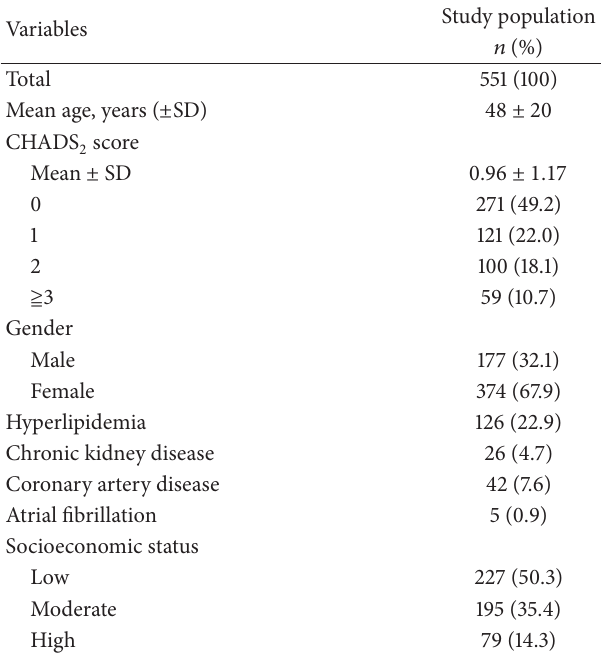
Table 1: Baseline characteristics of the patients with Cushing’s syndrome from 2002 to 2009 in Taiwan ( 𝑛 = 551